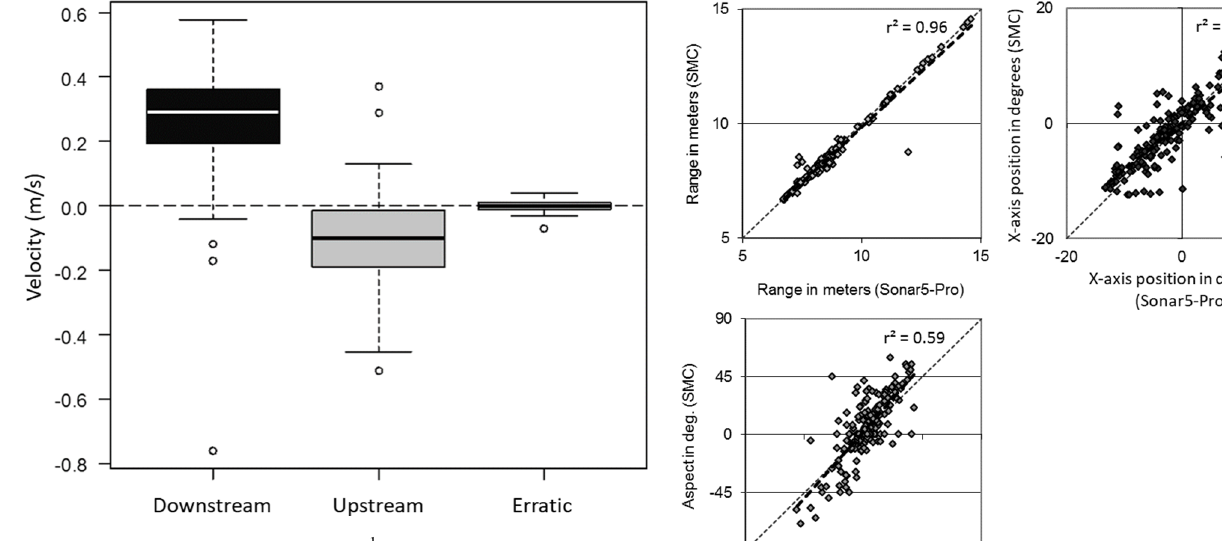
Fig. 3. Boxplot of the Velocity (m s (cid:1) 1 ) as a function of the visual description of the swimming direction of the 179 automatically tracked fi sh (downstream: n =75; upstream: n =95; erratic behaviour: n = 9).